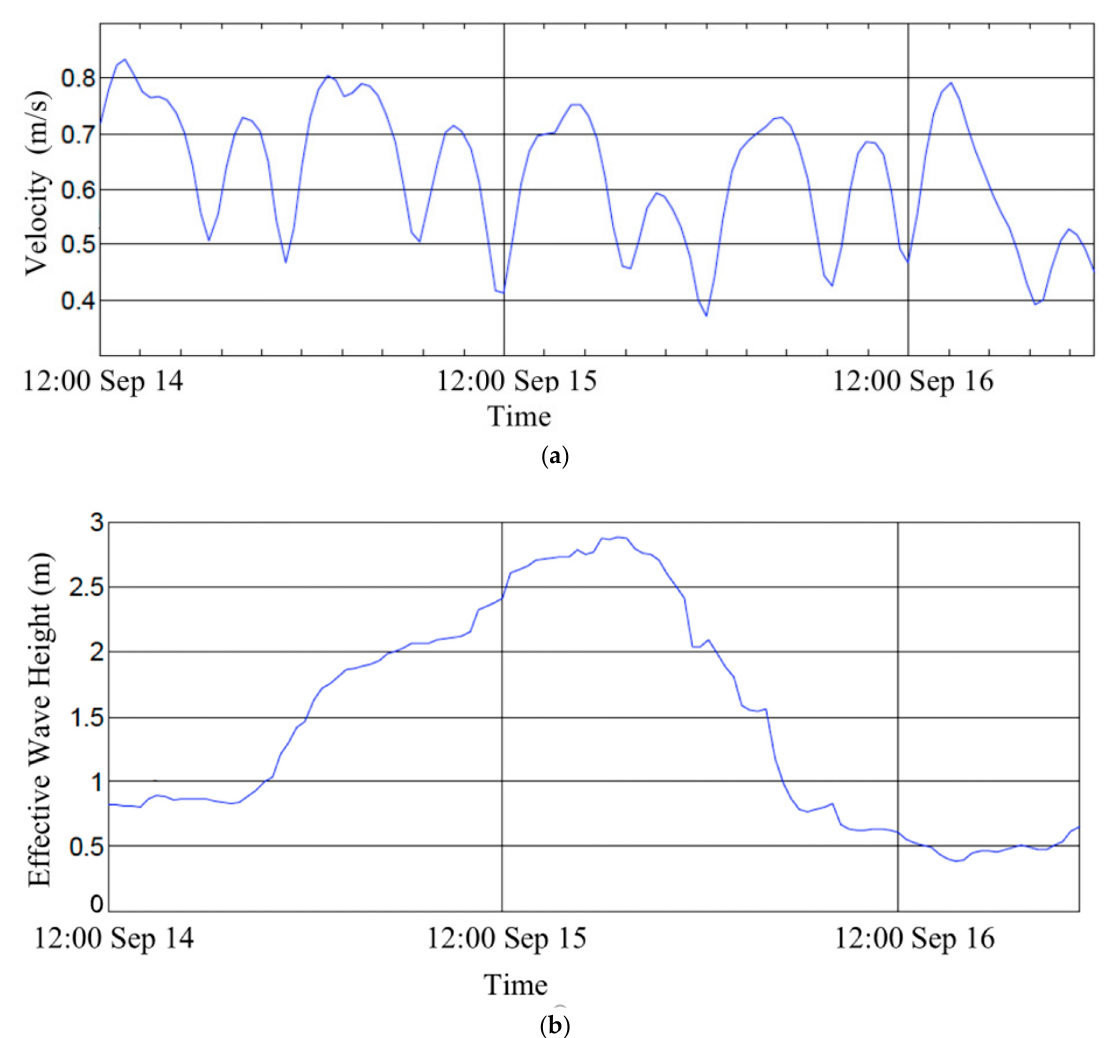
Figure 10. The change in flow velocity and effective wave height over time around KP300. ( a ) The flow velocity over time around KP300; ( b ) The effective wave height over time around KP300.